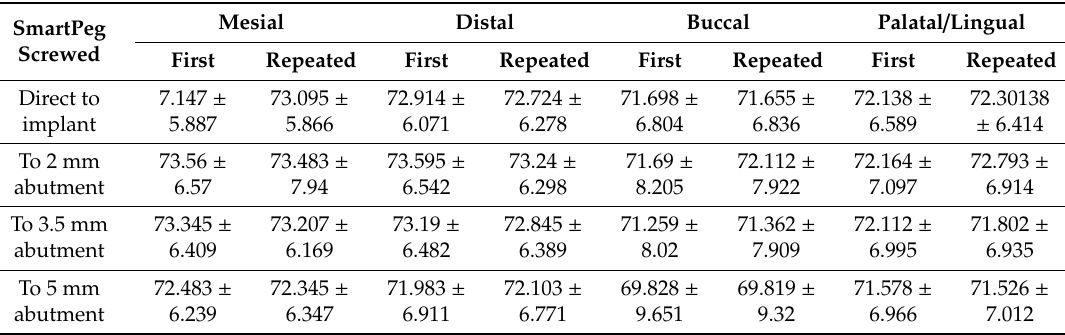
Table 1. Mean implant stability quotients (ISQ) values and SD according to Osstell´s probe position achieved during the first and the repeated measurements p < 0.001 (CI 95%).